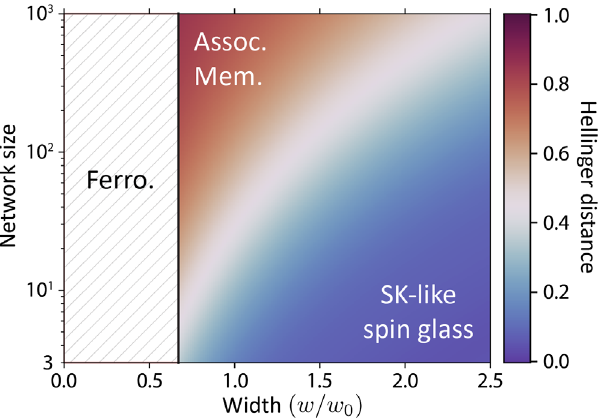
FIG. 7. Regimes of CCQED connectivity behavior versus width w and system size N . The three shaded regions correspond to ferromagnetic (F), associative memory, and SK-like spin glass (SG) regimes, as discussed in the text. Note that associative memories can still be encoded even in the spin glass regime due to SD dynamics; see Secs. V and